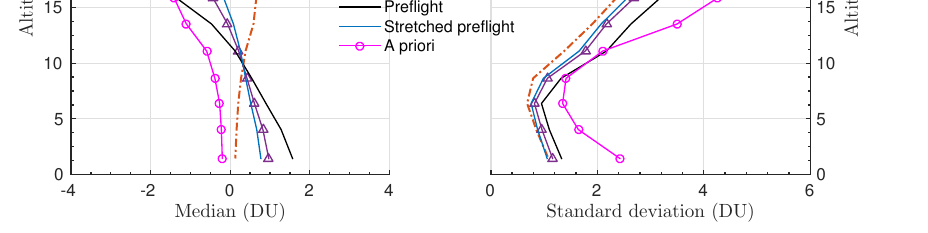
Figure 13. Same to Fig. 10 but for the UV2-only case.